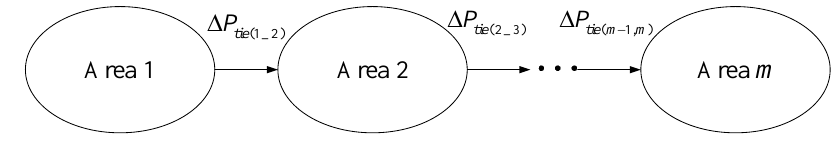
Figure 2. Diagram of the m -area cascade